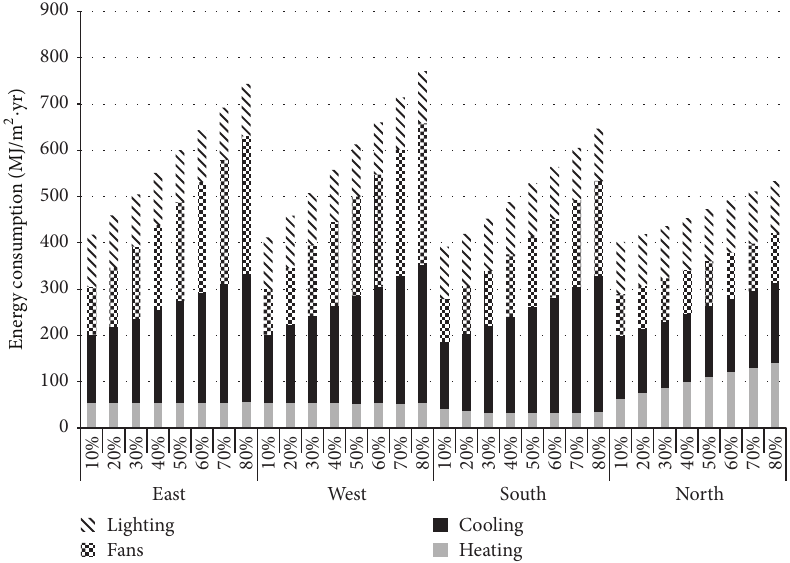
Figure 4: Energy consumption by various WWR and orientation (BASE